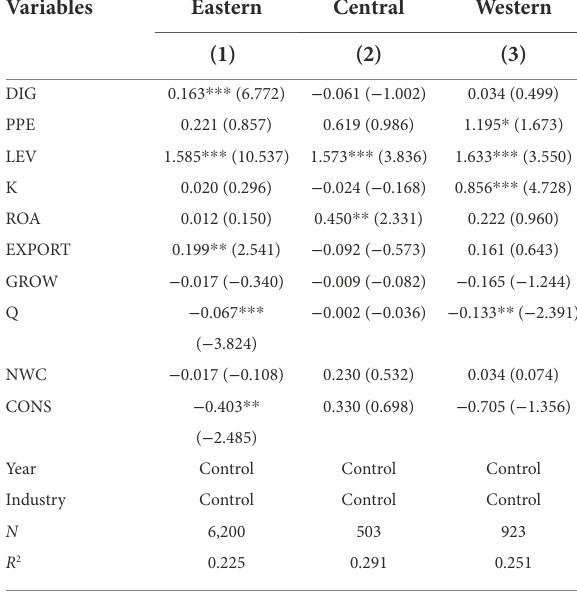
TABLE 12 Regression results of instrumental variables & replacing core explanatory